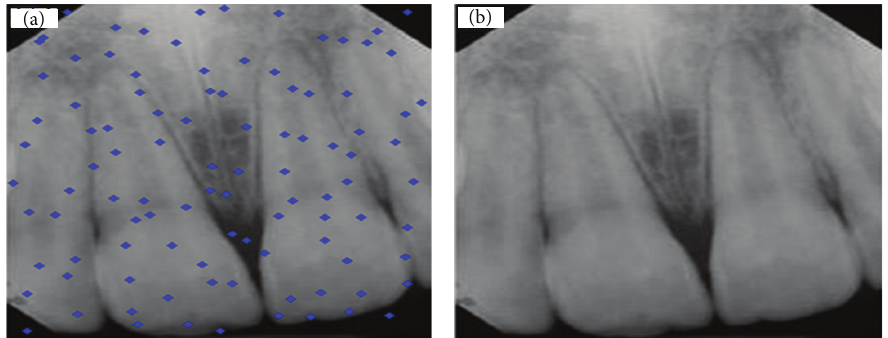
Figure 4: (a) Distribution of particles for detection of dental caries and restoration. (b) Teeth with no decay and restoration.